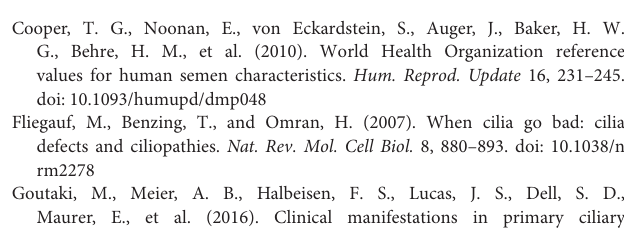
FIGURE 2 | defects of the axoneme, including absent of outer/inner dynein arms, CP defects (“9 + 0” “9 + 1”), and disorder of axoneme. Scale bars = 200nm. (B) ARMC4 staining was present mainly in the midpiece and principal piece of spermatozoa flagella from the control man, but absent or had a significant decrease in the spermatozoa from the ARMC4 -mutated men. CP, central microtubule pair (green arrows); ODA, outer dynein arm (yellow arrows); IDA, inner dynein arm (red arrows); MS, mitochondrial sheath; DMT, (blue arrows); ODF, outer dense fiber (purple